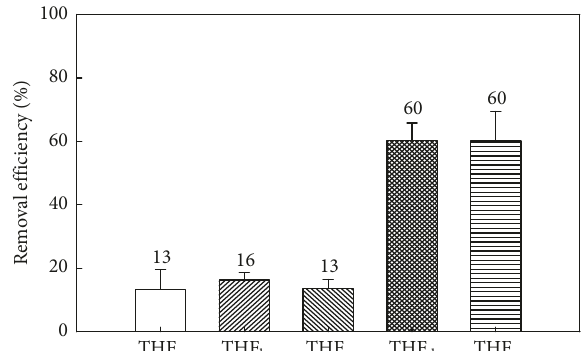
Figure 3: Arsenic adsorptive efficiencies of titanium hollow-fiber adsorbents with different compositions (initial As concentration: 0.2mg/L; quantity of adsorbents: 0.1g).